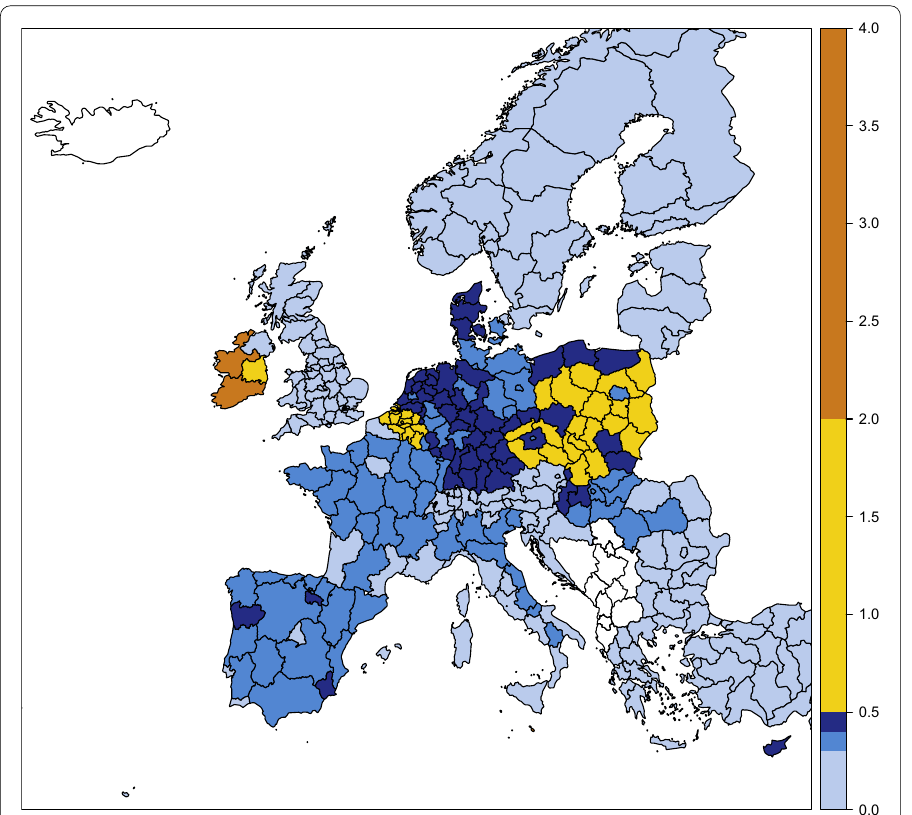
Fig. 5 Potential regional employment effect of a decline in UK import demand for final goods from the EU (no‑deal Brexit) in European NUTS‑2 regions. Employment effect in relation to total employment by region in percent. Source: World Input–Output Database, Eurostat (regional employment data) and own calculations. EuroGeographics for the administrative boundaries. Cuts in the color code at { 0.3,0.4,0.5,2.0 }